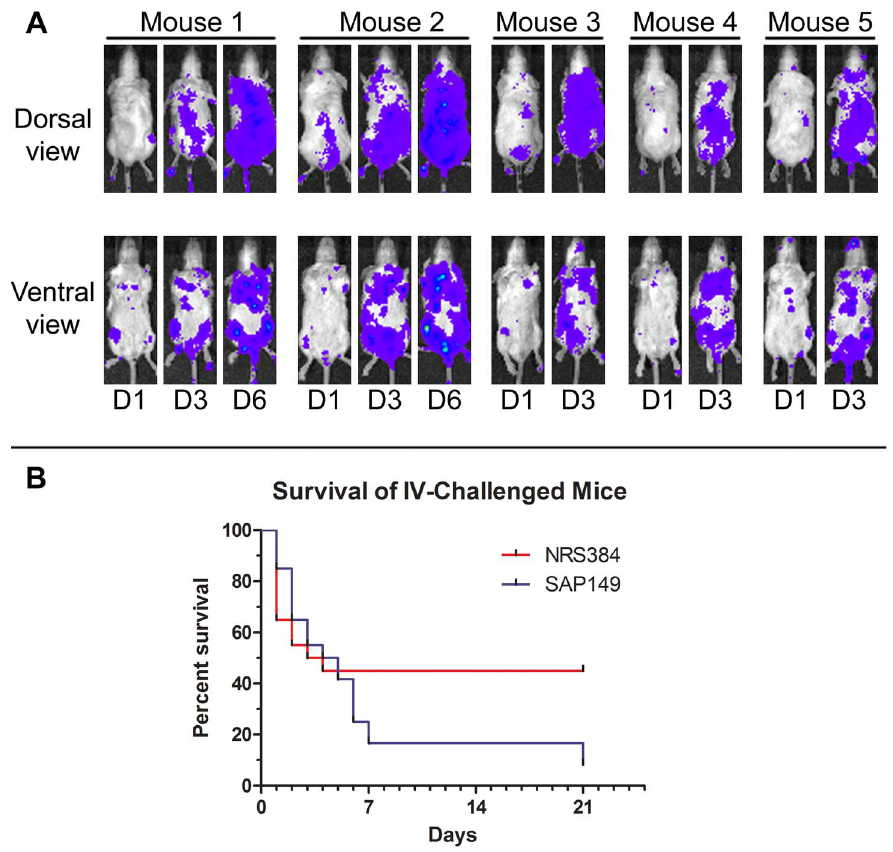
Figure 4. BALB/c intravenous infection with wild-type or luminescent NRS384. In an intravenous model, mice were injected via the tail vein with either the wild-type USA300 strain (NRS384) or the luminescent strain (SAP149). Mice injected with the luminescent strain were imaged over the course of 6d (A); images are representative. There was no statistically significant difference in survival of mice injected with the two strains (B) by either the log-rank (Mantel-Cox) Test ( P =0.46) or the Gehan-Breslow-Wilcoxon Test ( P =0.68); n=20 mice per